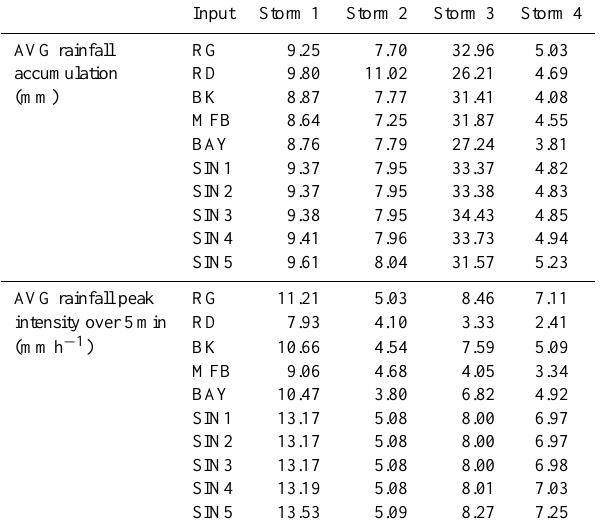
Table 2. Areal average rainfall accumulations and peak intensities for the different rainfall products.